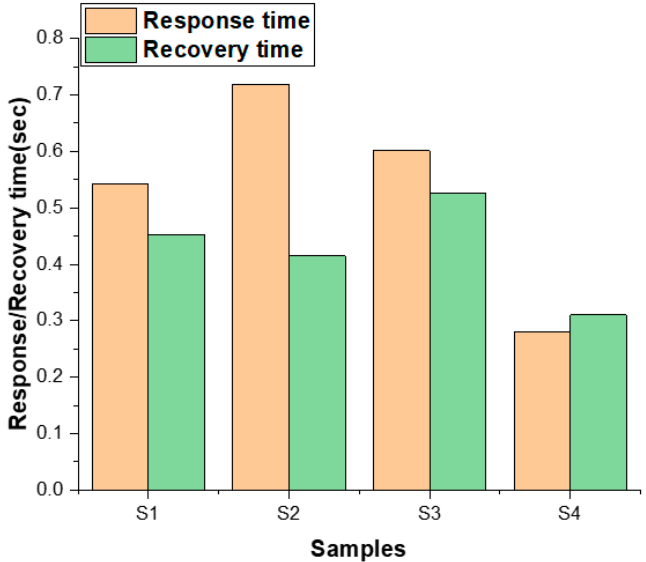
Figure 16. The response and recovery time of each sample: S1, S2, S3, and S4.